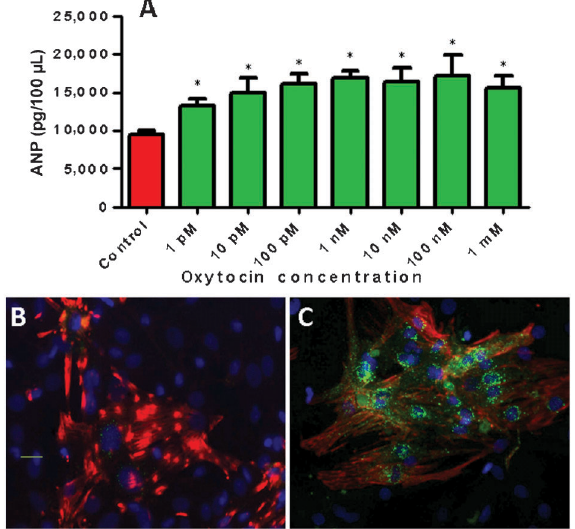
Figure 1. Newborn rat cardiomyocyte culture treated with oxytocin release atrial natriuretic peptide (ANP) to the medium and accumulate ANP in the perinuclear region of the cells. A , Radioimmunoassay of ANP from cultures treated with different oxytocin concentrations for 24 h. *P , 0.05, compared to control (one-way ANOVA). B , Control cardiomyocyte culture stained with specific marker, troponin T (red) and nuclear Dapi stain (blue). C , Cardiomyocytes treated for 24 h with 10 pM oxytocin expressed green fluorescence specific for